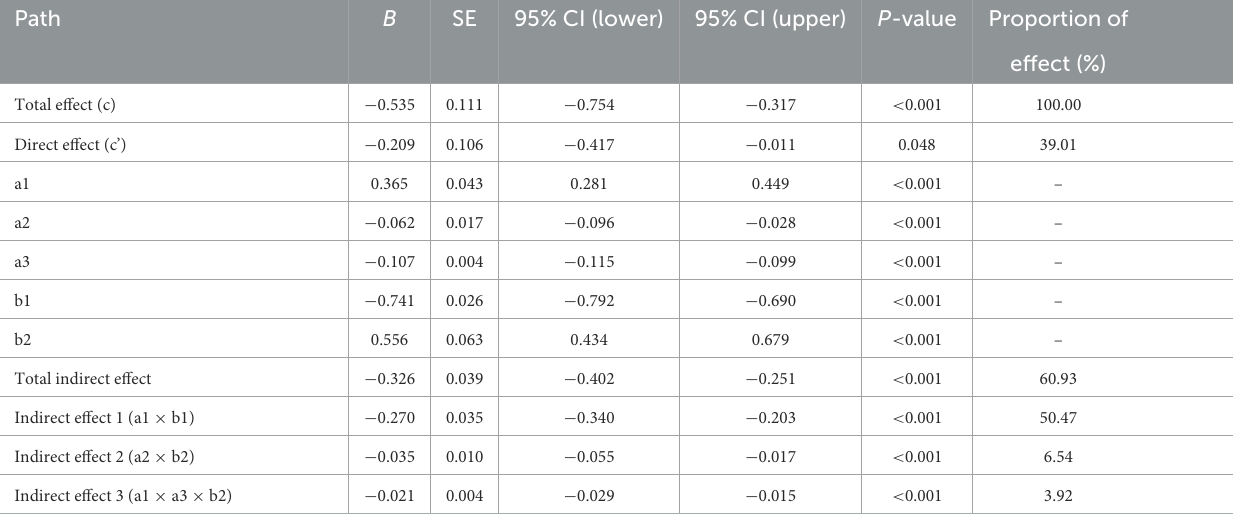
TABLE 3 The serial mediating effect of waist-to-calf circumstance ratio (WCR) and cognitive